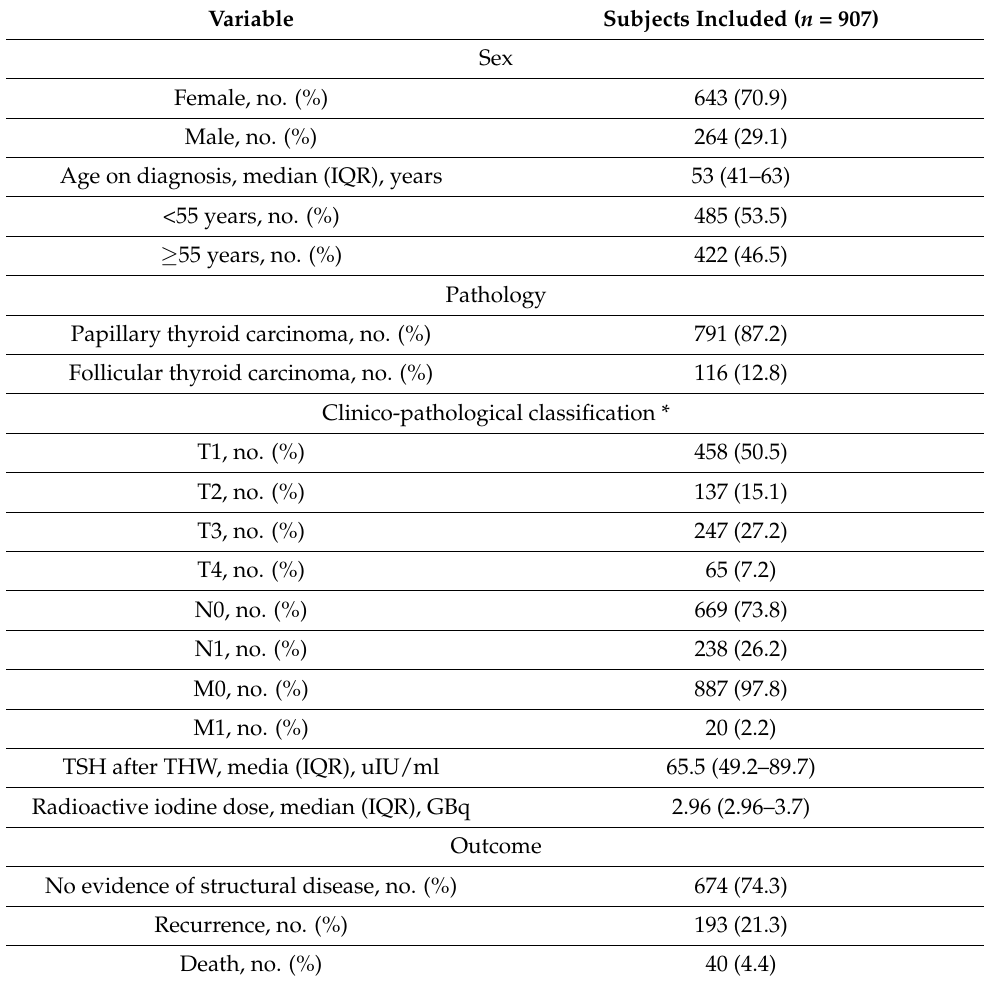
Table 1. Characteristics of the study